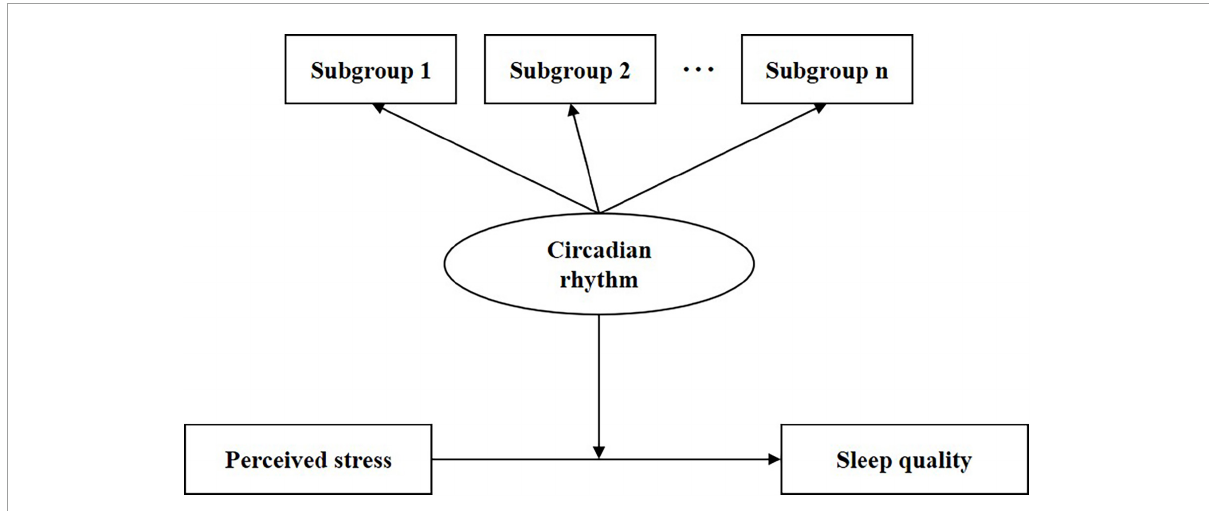
FIGURE1 The hypothetical framework for circadian rhythms and sleep quality in nursing